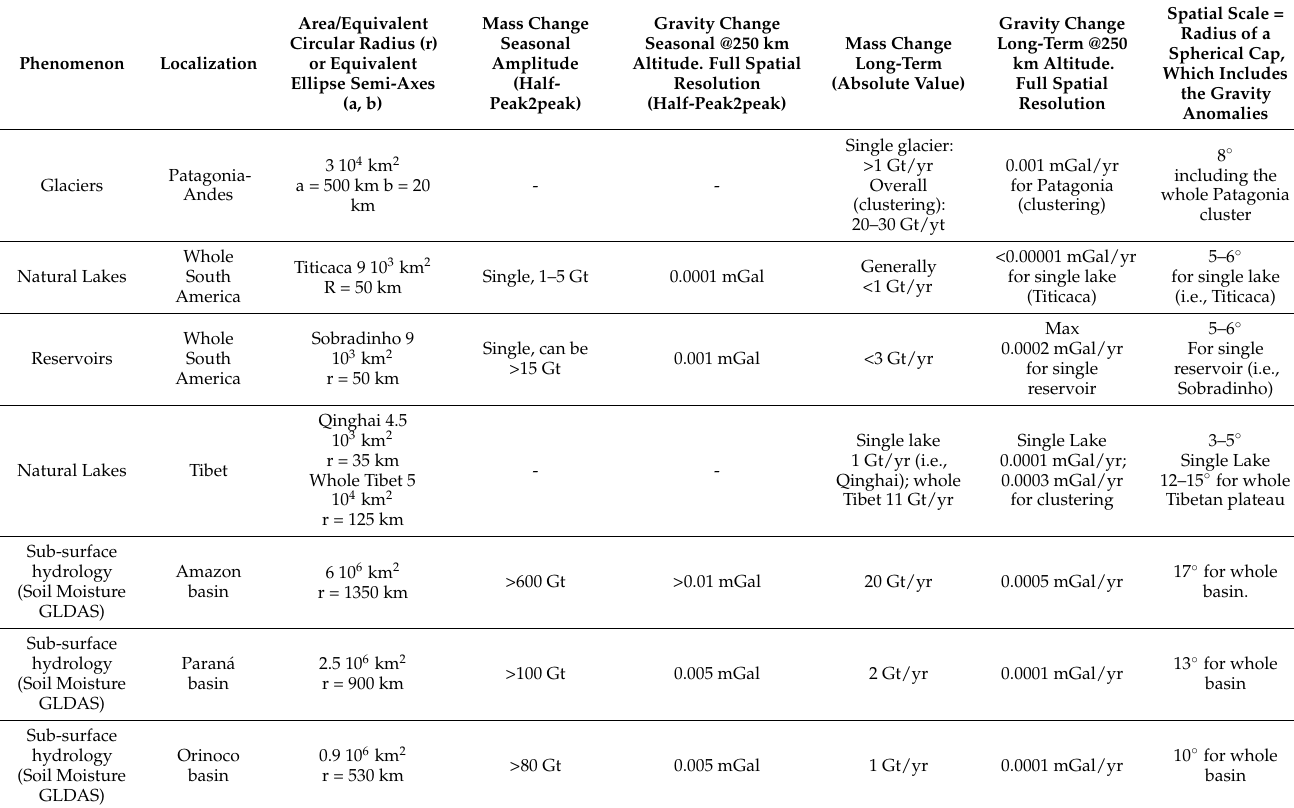
Table 1. Summary of the simulated phenomena and gravity